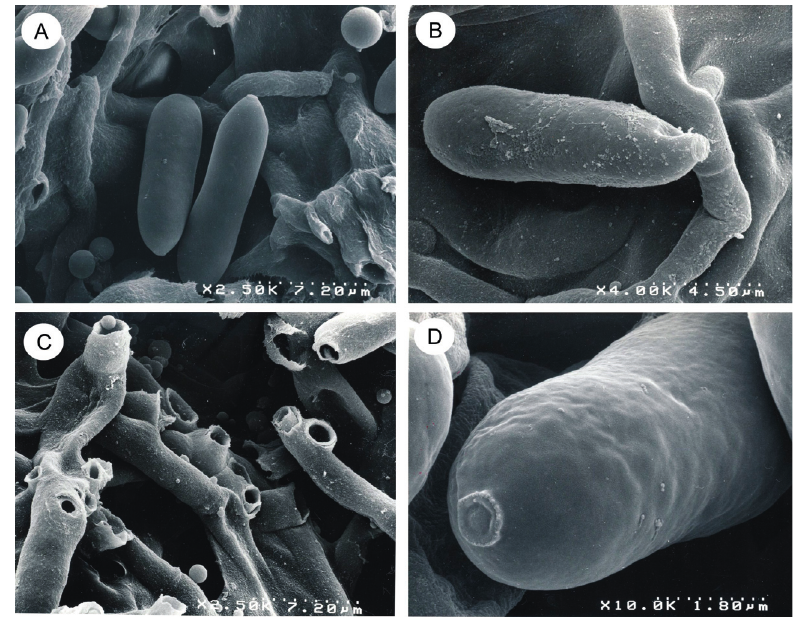
Figure 5. Colletotrichum clavatum IMI 398854 (ex-type). SEM view of clavate conidia (A and B), phialides with con- idiogenous loci (C) and ring-like basal peduncle of a conidium (D).